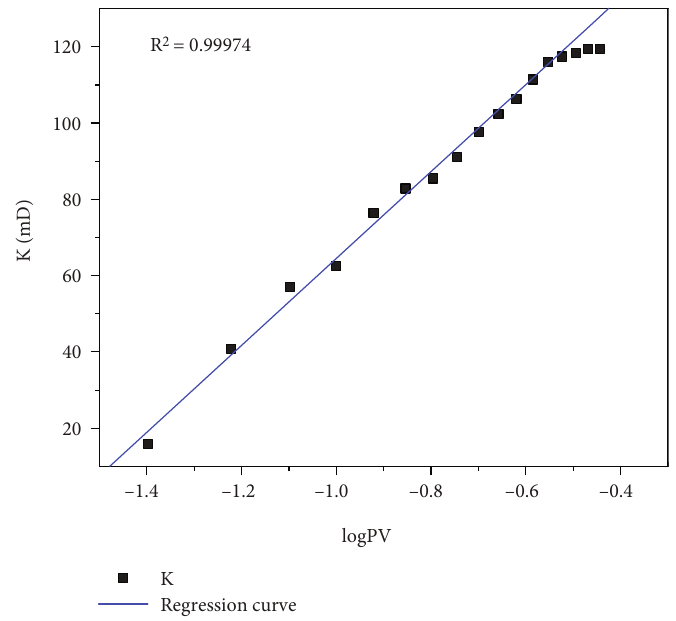
Figure 2: E ff ect of nanosolution on permeability of low permeability core.